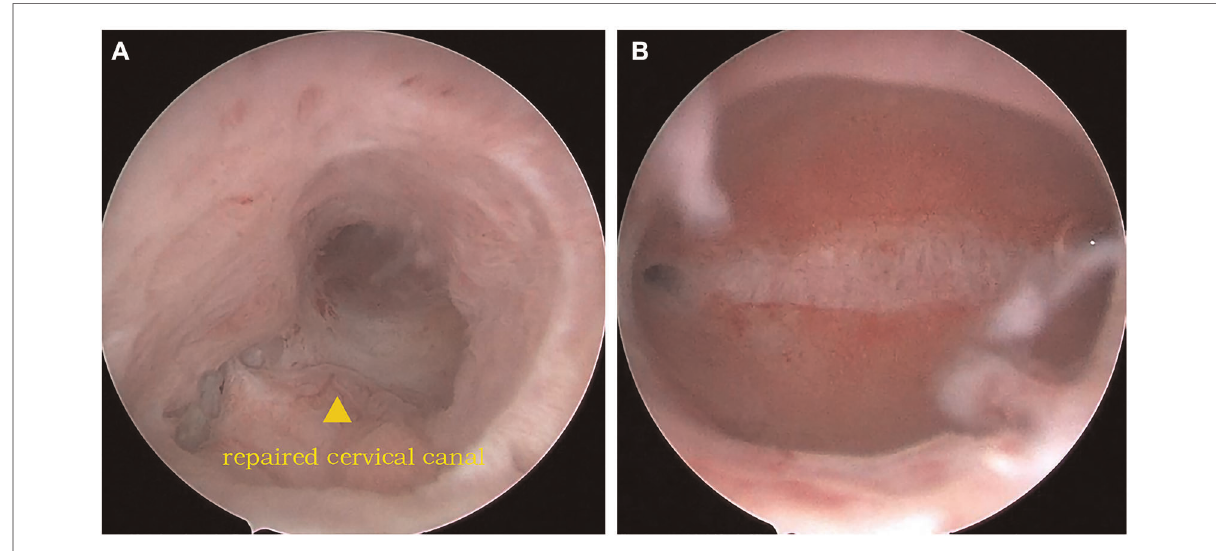
FIGURE 3 ( A ) The anastomotic stoma of the uterine isthmus and cervix; ( B ) normal uterine